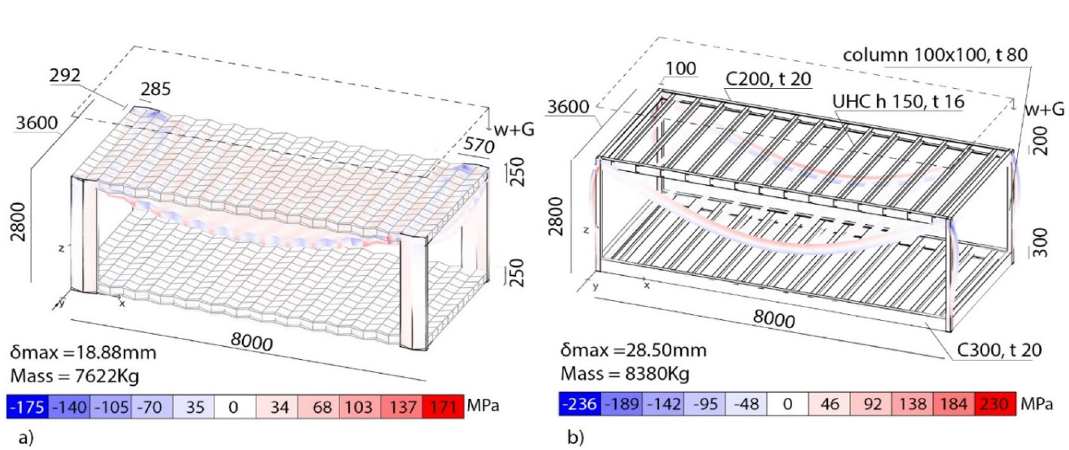
Figure 6. Considered deployable modular sections and structural dimensions. ( a ) Deployable floor and roof. ( b ) Modular origami-like unit.